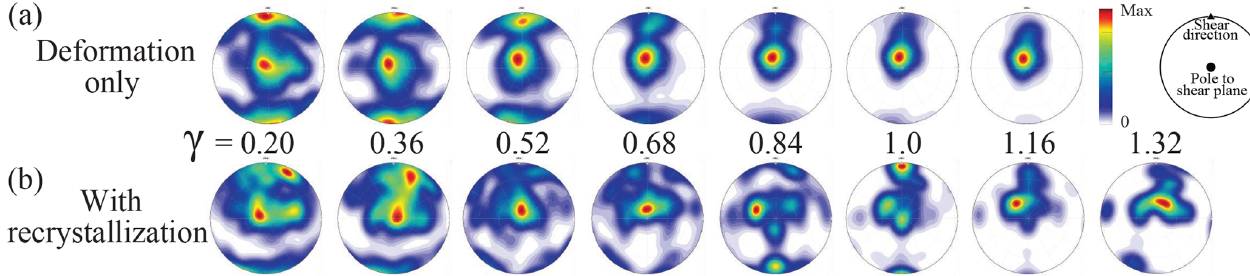
Figure 9. Lower-hemisphere, equal-area stereonets of c axes from numerical models described by Llorens et al. (2017). The data are extracted from high-strain-rate domains in the models and are presented as a function of shear strain. The color contours of each stereonet are nor- malized to its own maximum. (a) Model SSH0: deformation with no recrystallization. (b) Model SSH25: deformation with recrystallization (strain-induced grain boundary migration) and